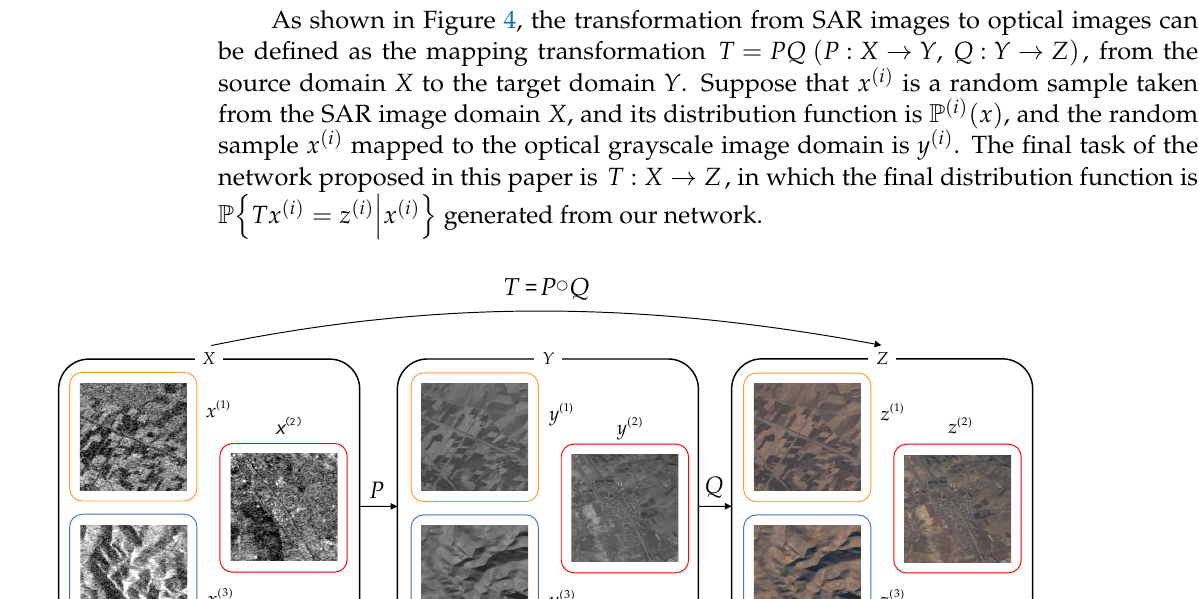
Figure 3. Overview of different methods. ( a , b ) CycleGAN. It is essentially two mirror-symmetric GANs, which share two generators G and F with discriminators D Y and D X respectively, and it uses GAN loss and cycle-consistency loss; ( c ) pix2pix, which directly transforms the image from the X domain to the Z domain, using GAN loss and L1 loss; ( d ) pix2pixHD. Different from pix2pix, it has two generators, G 1 and G 2 , and its loss functions are GAN loss, Feature-matching loss, and Content loss; ( e ) the method proposed in this paper. It uses the intermediate state y as the transition, and its loss functions are GAN loss, Feature-preserving loss, and L1 loss.